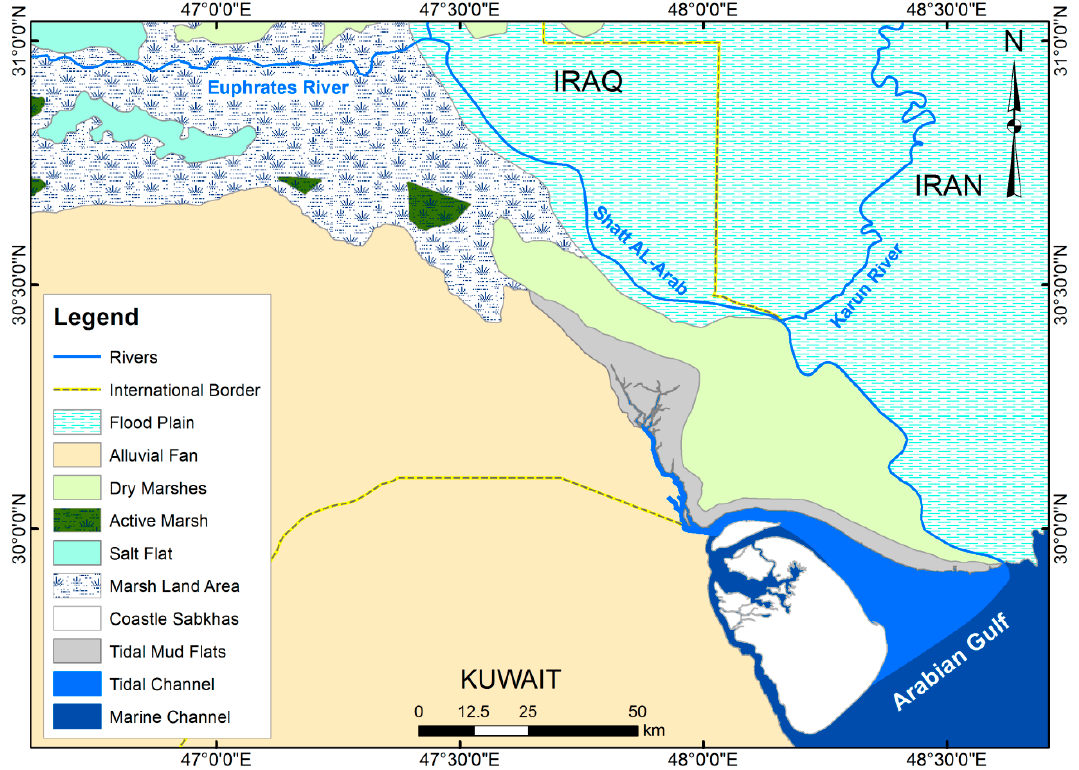
Figure 2. Geomorphological formation of the study area (Ministry of Industry and Minerals, Basra Geological,